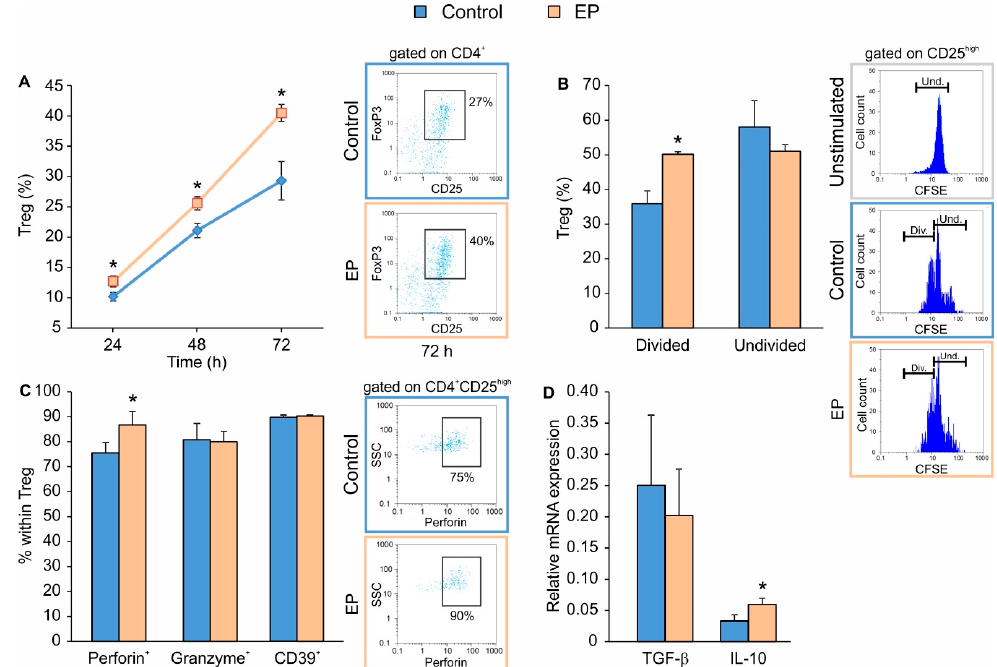
Figure 1. The effect of ethyl pyruvate (EP) on Treg in vitro. CD4 + CD25 − T lymphocytes were stimulated for 24 h with a conventional Treg differentiation cocktail (control) and then additionally treated with 125 μ M EP. ( A ) Treg (CD4 + CD25 high FoxP3 + ) proportion, at indicated time points after the addition of EP. Representative dot plots for the 72nd h are shown on the right-hand side. ( B ) Carboxyfluorescein succinimidyl ester (CFSE)-based proliferation of Treg (CD4 + CD25 high ) was evaluated by flow cytometry (divided, Div. and undivided, Und. cells, with representative histogram plots shown on the right-hand side) 48 h after EP treatment. Unstimulated cells were stained with CFSE and served as the control for setting the threshold for undivided cells. ( C ) The proportion of Treg expressing perforin, granzyme or CD39, 72 h after EP treatment. Representative dot plots for perforin + Treg are shown on the right-hand side. ( D ) mRNA expression of Tgf- β and Il-10 in cultures treated with or without EP. * p < 0.05 represents the significant difference of EP-treated cells in comparison to control cells.